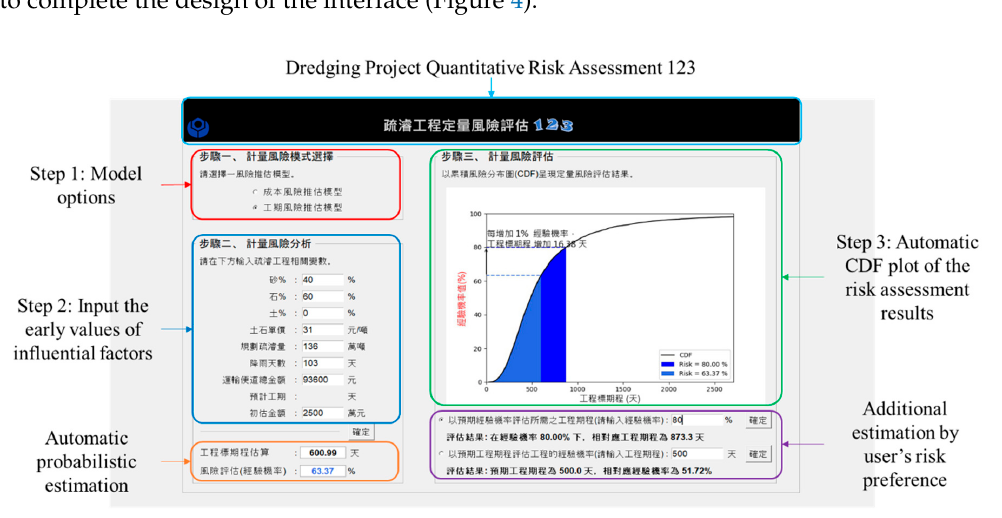
Figure 4. System demonstration.